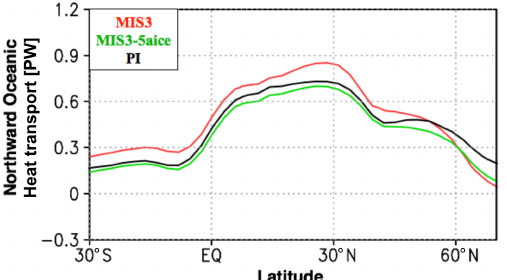
Figure 7. Northward oceanic heat transport over the Atlantic Basin simulated from the AOGCM. Red represents MIS3, green repre- sents MIS3-5aice, and black represents PI. The climatology of the last 100 years is used to create these